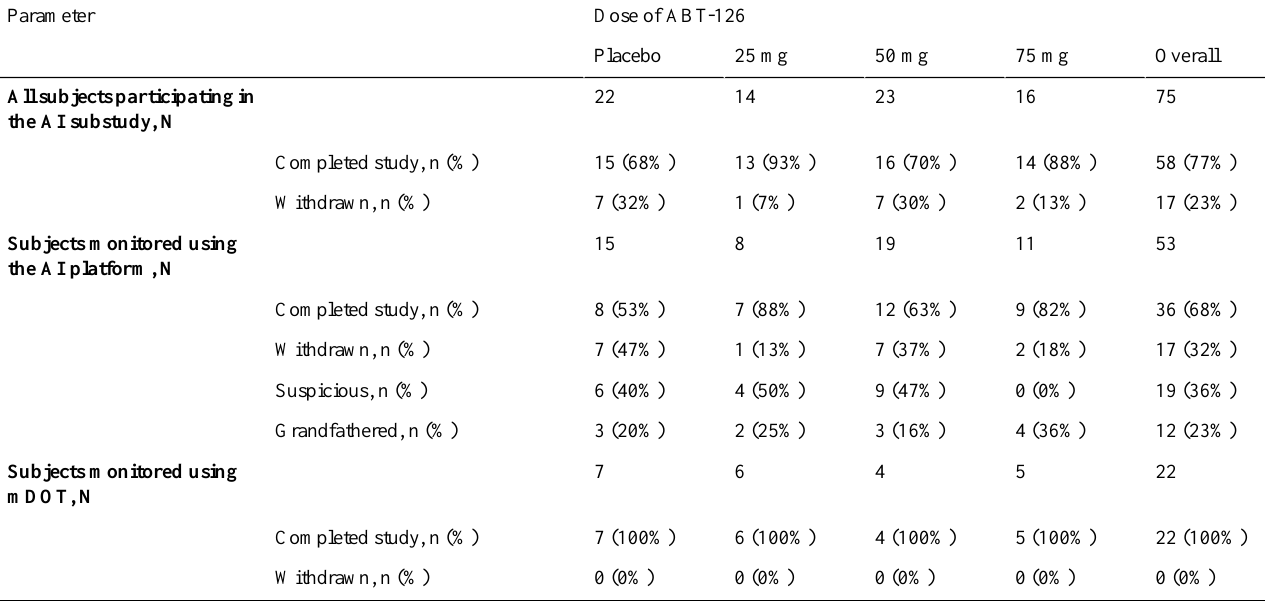
Table 1. Subject disposition (AI substudy). AI: artificial intelligence; mDOT: modified directly observed therapy; mg: